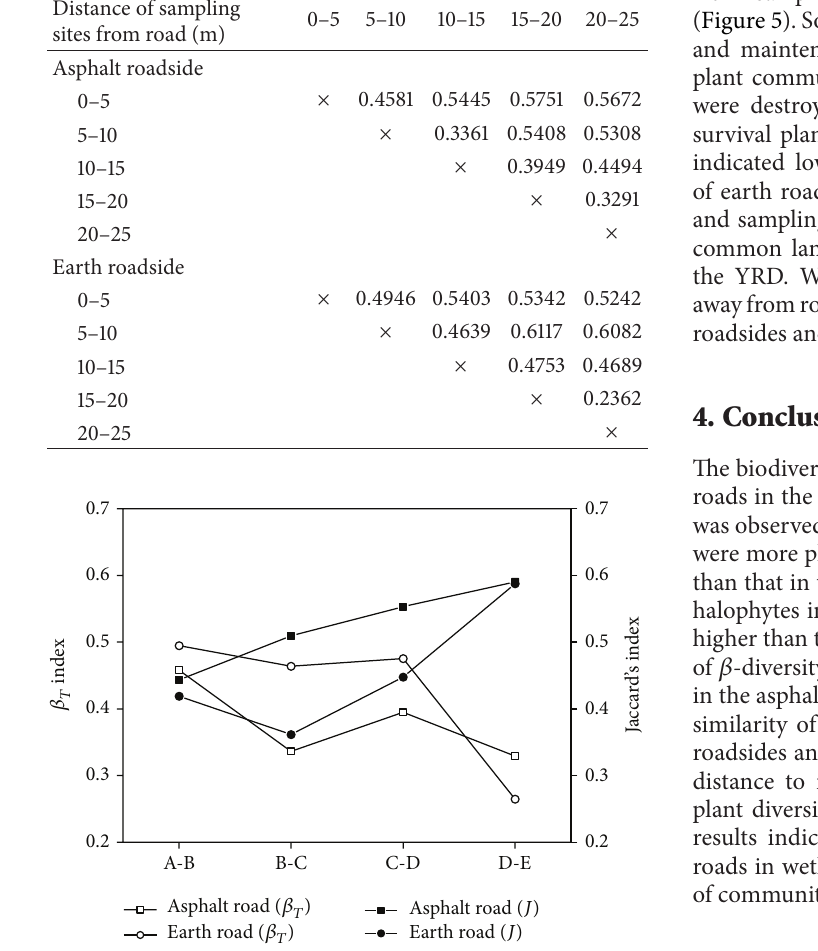
Table 2: Matrix of 𝛽 -diversity indices measured by numerical data from sampling sites.